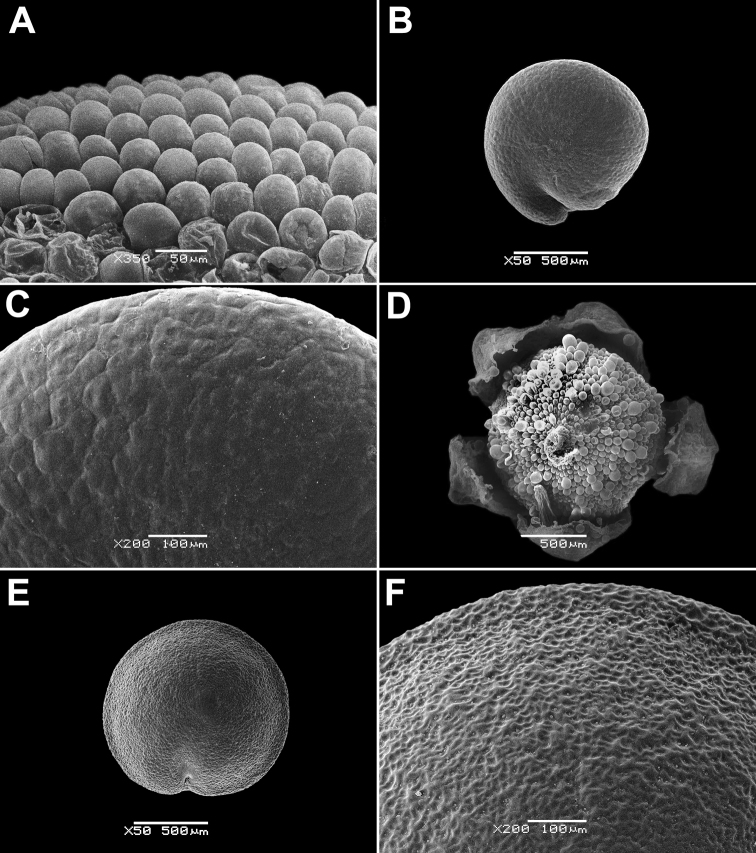
SEM micrographs of Chenopodium fruits and seeds. A pericarp surface of C.karoiB, C seed of C.karoiD fruit of C.bengalense enclosed in perianth E, F seed of C.bengalense. Magnification: 350× (A), 50× (B, D, E), 200× (C, F).